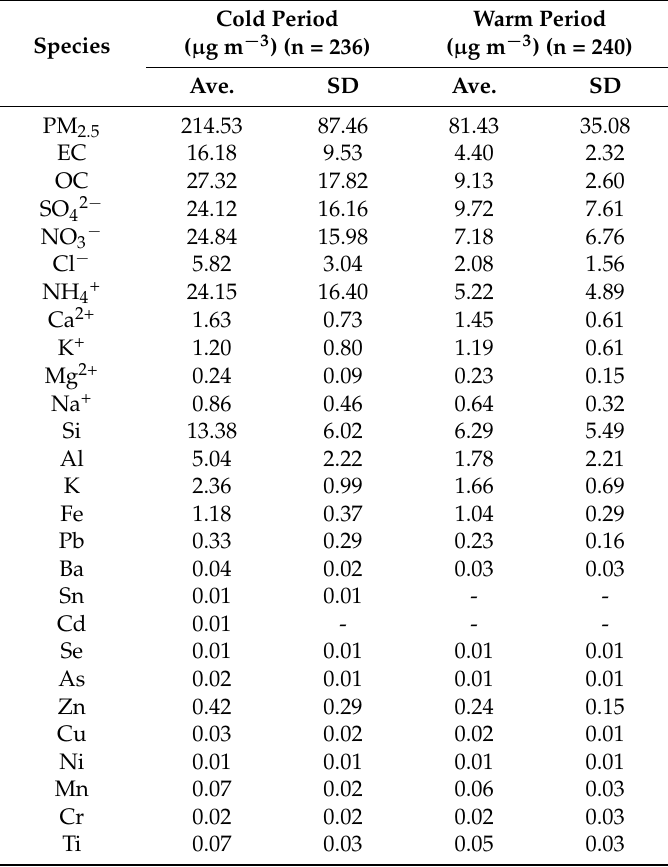
Table 1. Mass concentrations of PM 2.5 and levels of OC, EC, ions, and trace elements for all sites in the cold and warm periods (off-line data, data derived from filter membrane sampling